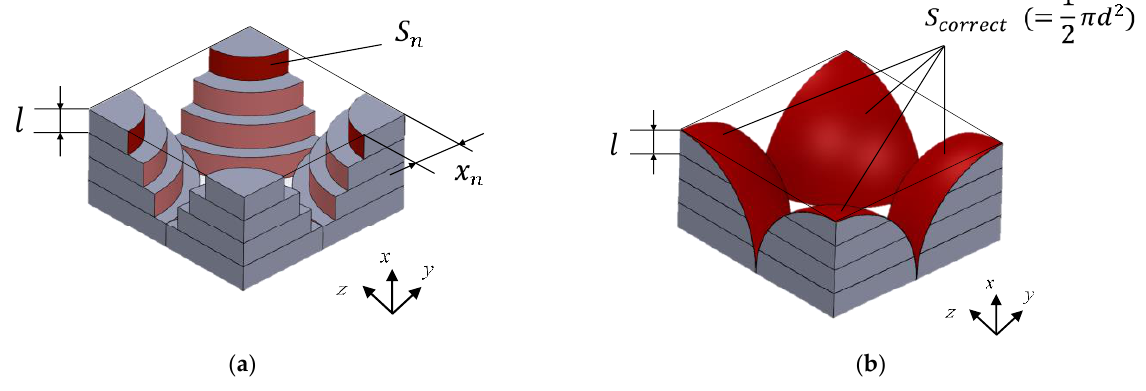
Figure 6. Divided element for the half sphere: ( a ) cylindrically approximated surface area; ( b ) true surface area.